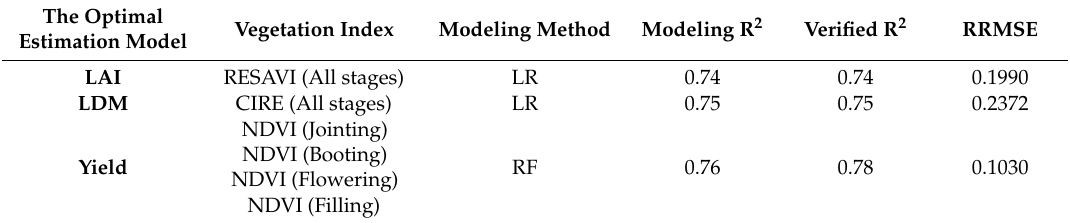
Table 7. The optimal estimation model of LAI, LDM, and yield in this